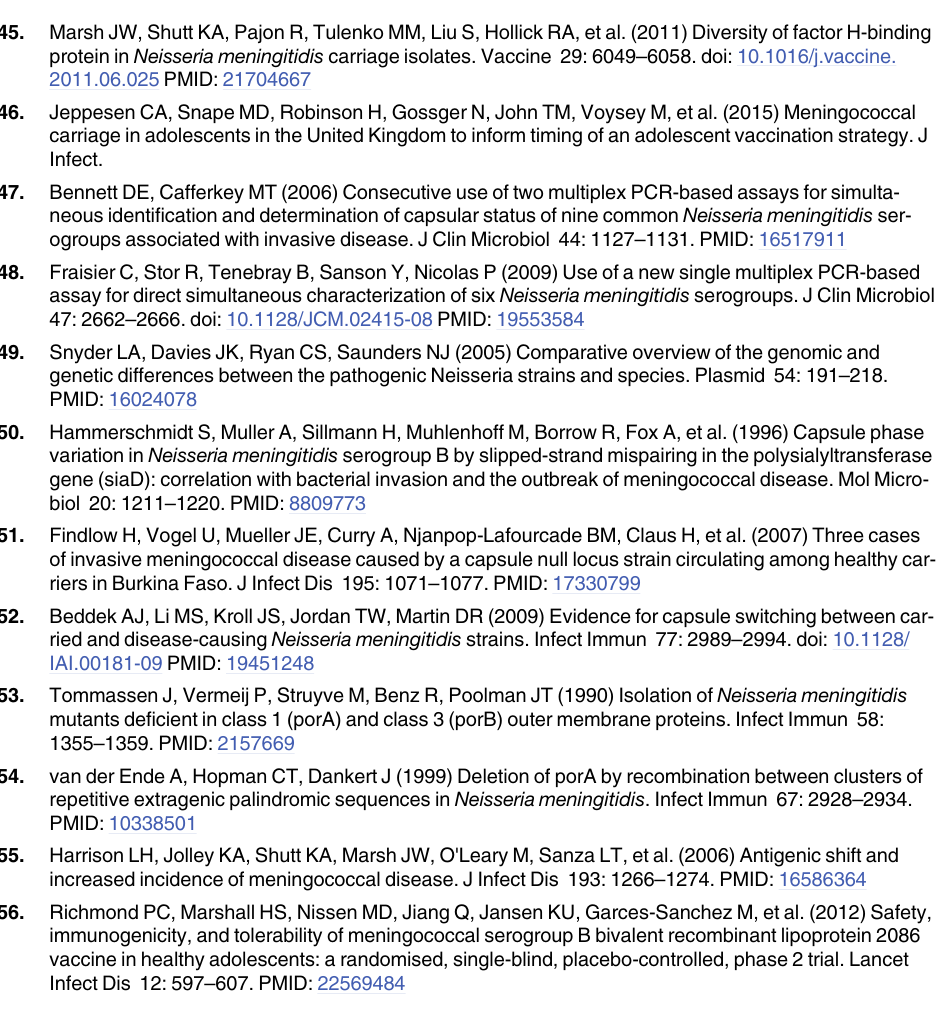
PLOS ONE | DOI:10.1371/journal.pone.0132140 July 6,